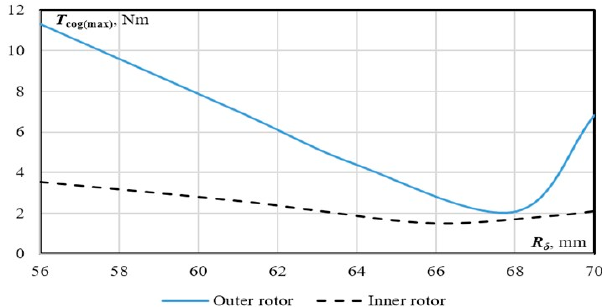
Figure 9. Dependence of the maximum cogging torque on the air-gap radius R δ in single-phase TFM with an outer and inner rotor .